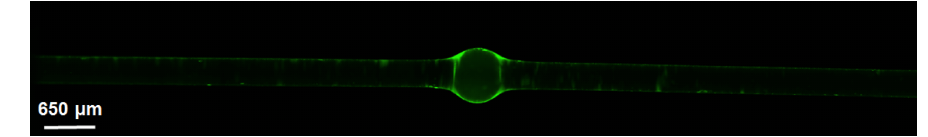
Figure 13. Mosaic image taken by the Zeiss Axio Observer microscope following the sample scan along the microcapillary Z axis. The analysis reveals that the bubble fluorescence intensity is around three-fold higher than that of the